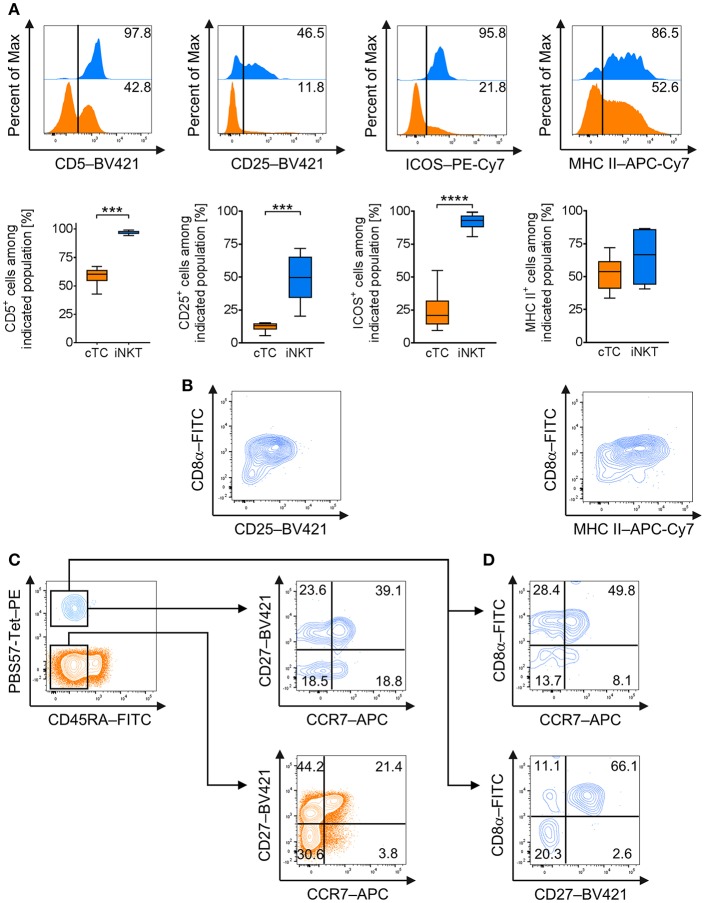
Expression of effector and memory cell-associated markers on naïve porcine iNKT cells. Expression of surface markers associated with effector functions and memory status on naïve peripheral iNKT cells was analyzed by flow cytometry. (A) Representative flow cytometric plots of CD5, CD25, MHC II, and ICOS expression by iNKT cells (blue) and cTC (orange). Summarized data show frequencies of iNKT cells or cTC expressing CD5, CD25, MHC II, and ICOS (mean (SD), n = 6). (B) Representative flow cytometric plots showing differential expression of CD8a and CD25 or MHC II on iNKT cells. (C) Expression of CD45RA (left) on iNKT cells and cTC. CD45RA− cTC (middle) and iNKT cells (right) were further investigated for expression of CD27 and CCR7 and divided into CD27+/CCR7+ central memory cells, CD27+/CCR7− transitional memory cells, CD27−/CCR7− effector memory cells, and CD27−/CCR7+ activated effector memory cells. (D) Differential expression of CD8α and CCR7 or CD27. Representative plots and histograms of at least three experiments are shown. ***p < 0.001, ****p < 0.0001, paired t-test.